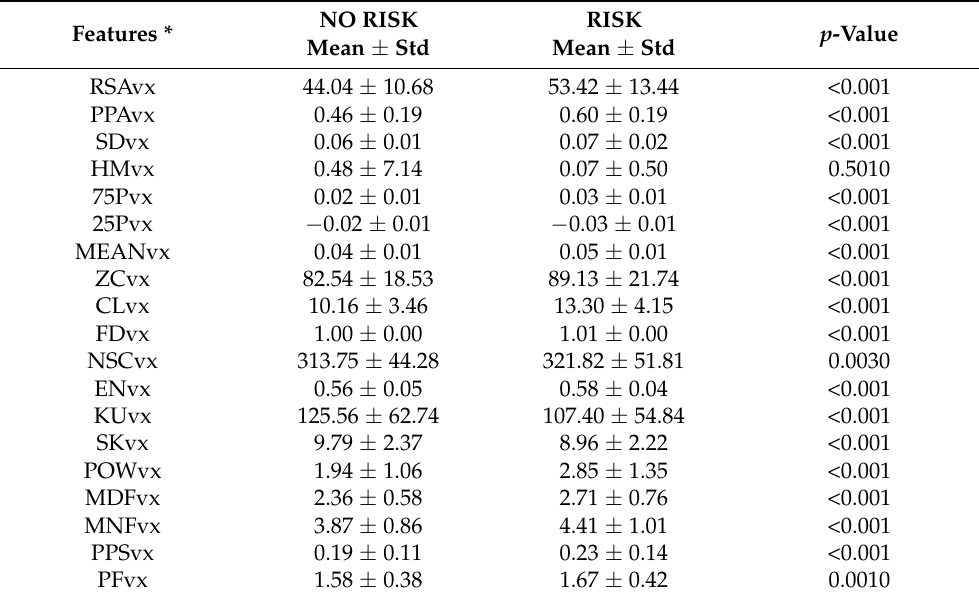
Table 7. Paired t -test NO RISK/RISK classes for each feature extracted from x -axis angular velocity (vx). Features